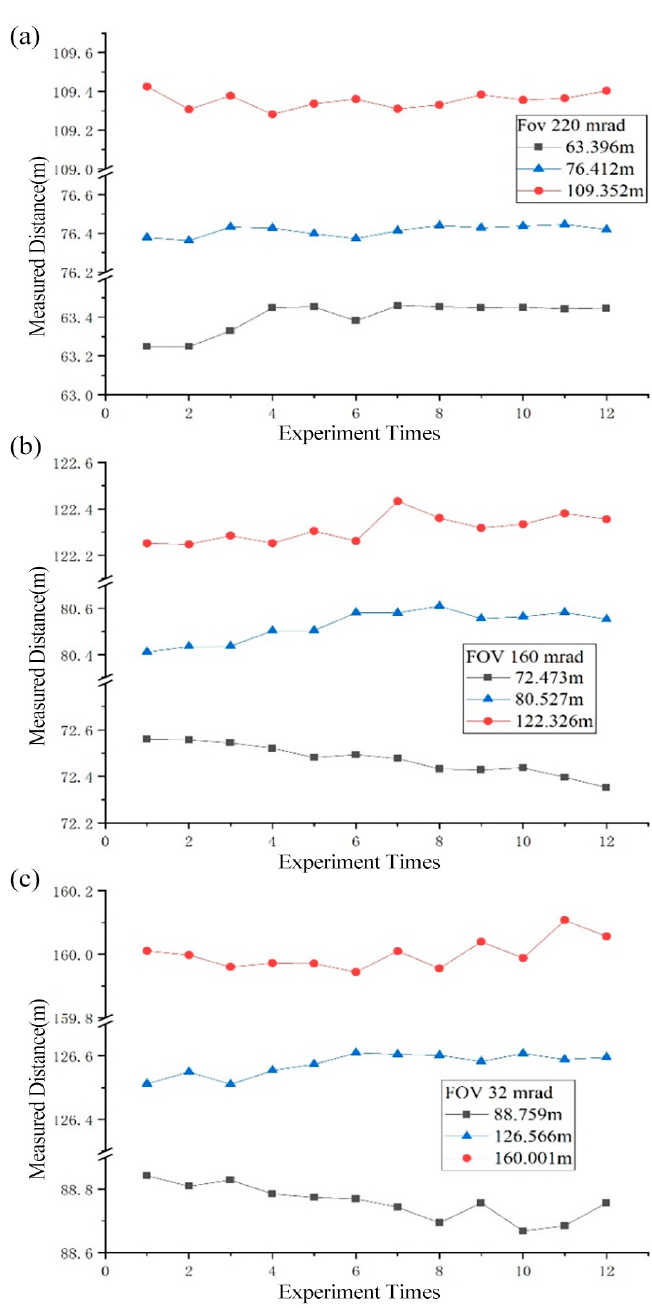
Figure 9. Search data with FOVs of ( a ) 220 mrad, ( b ) 160 mrad, ( c ) 32